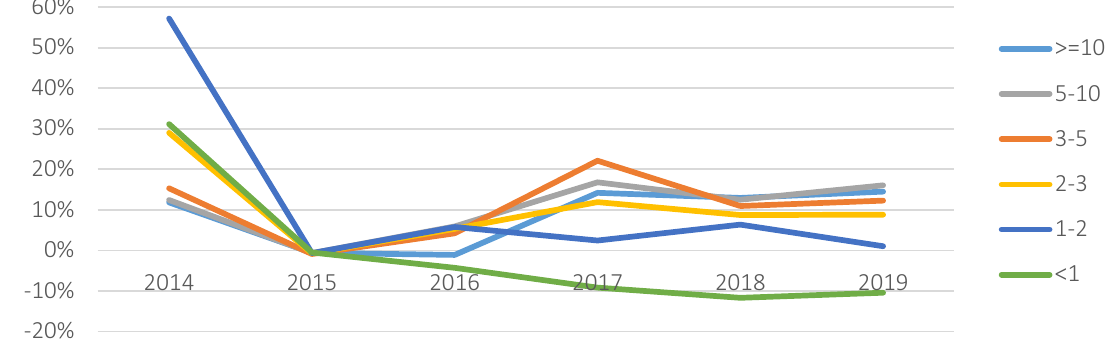
Figure 3. Growth rates of JIF groups,